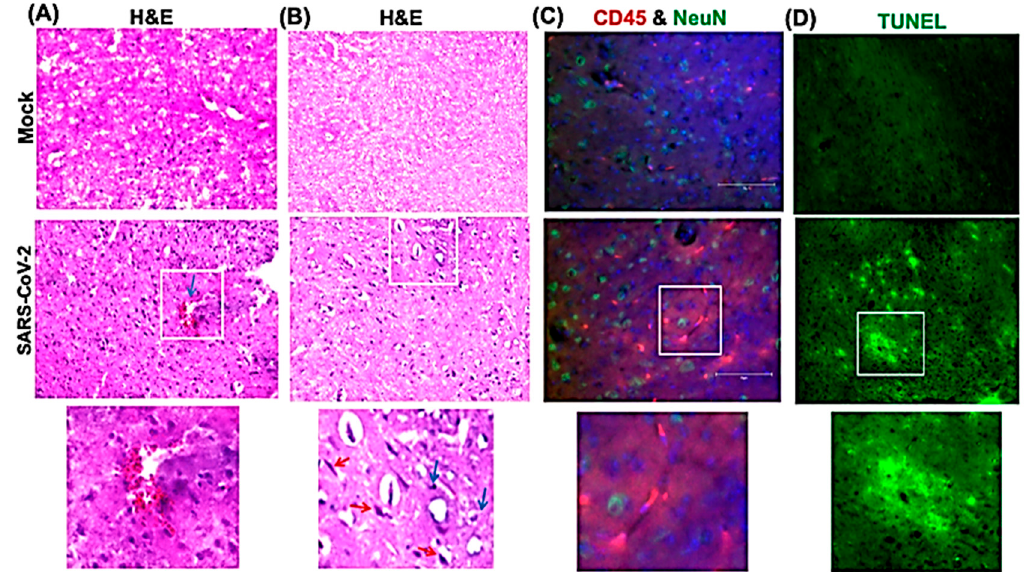
Figure 6. Histopathological analysis of SARS-CoV-2-infected brains. Hematoxylin and eosin (H&E) staining of brain sections from mock and SARS-CoV-2-infected mice on day 6 after infection. ( A , B ) Brain sections show perivascular hemorrhage, enhanced leukocyte infiltration (blue arrows) and neuronal cell death (red arrows). ( C ) Brain sections are stained for CD45 (Red, leukocyte marker) and NeuN (Green, neuronal cell marker). Nuclei are stained with DAPI (blue). ( D ) A terminal deoxynucleotidyl transferase nick end labeling (TUNEL) assay was conducted on brain sections from mock and SARS-CoV-2-infected mice on day 6 after infection to detect apoptotic cells. The boxed areas in the second row of panels are enlarged in the bottom row of panels. The photomicrographs shown are representative of the images obtained from five animals. Bars, 20 μ m.